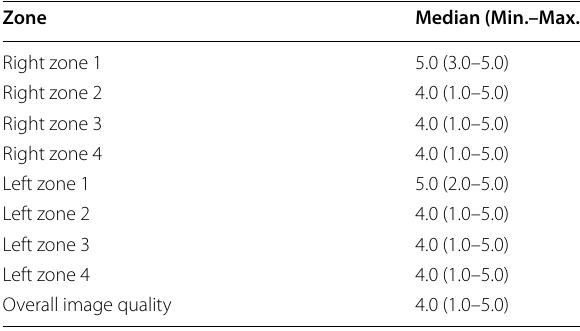
Table 4 Image quality by zone and overall, n